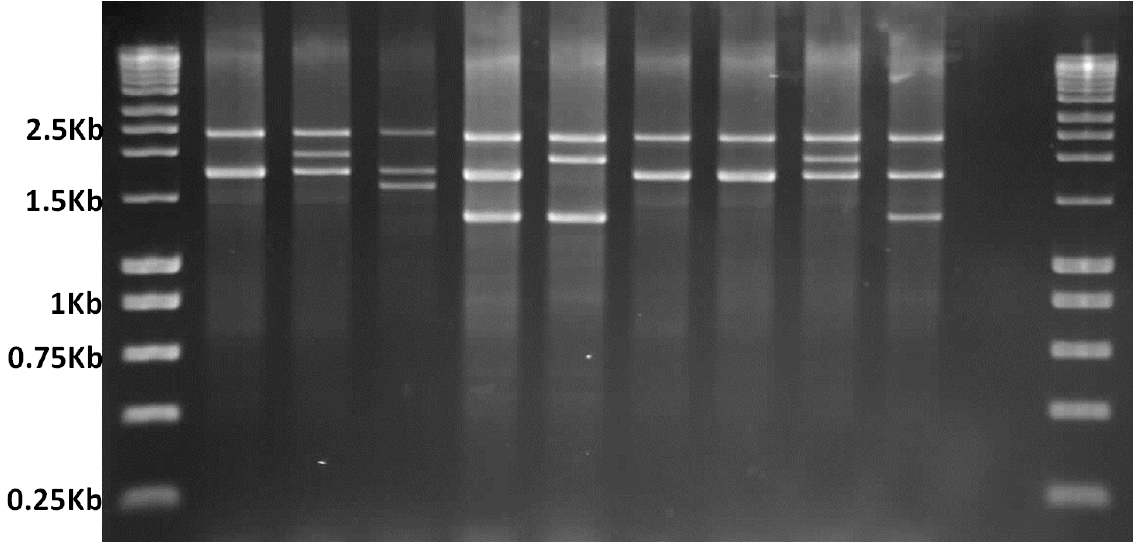
Figure 1. Multiplex-Gap PCR genotype analysis of the α -globin gene cluster on agarose gel electrophoresis. Lanes 1 and 12 (left to right) show DNA marker ladders; 2350 bp band on lane 2 depicts the internal control and 1800 bp band indicates the presence of normal α 2 globin gene. Lanes 3–5 are positive controls for heterozygous −α 3.7 deletion, −α 4.2 deletion, and −− SEA deletion; Lanes 6–10 are patients where lane 6 shows compound heterozygosity for −α 3.7 and −− SEA deletions; Lanes 7 and 8 “none of the deletion tested present”; Lane 9 −α 3.7 deletion; Lane 10 −− SEA deletion; and Lane 11 is non-template